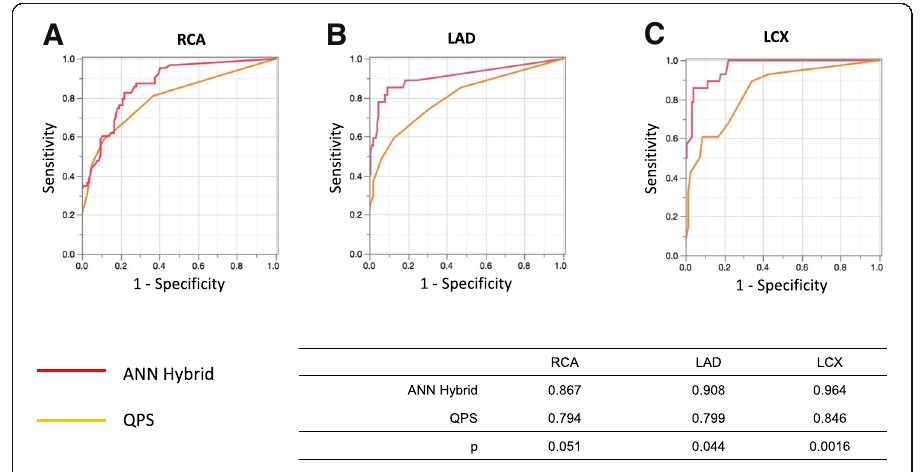
Fig. 5 Areas under ROC curves derived from analysis of RCA ( a ), LAD ( b ), and LCX ( c ) by ANN and QPS. ANN artificial neural network, LAD left anterior descending coronary artery, LCX left circumflex coronary artery, QPS quantitative perfusion single-photon emission computed tomography, RCA right coronary artery, ROC receiver operating